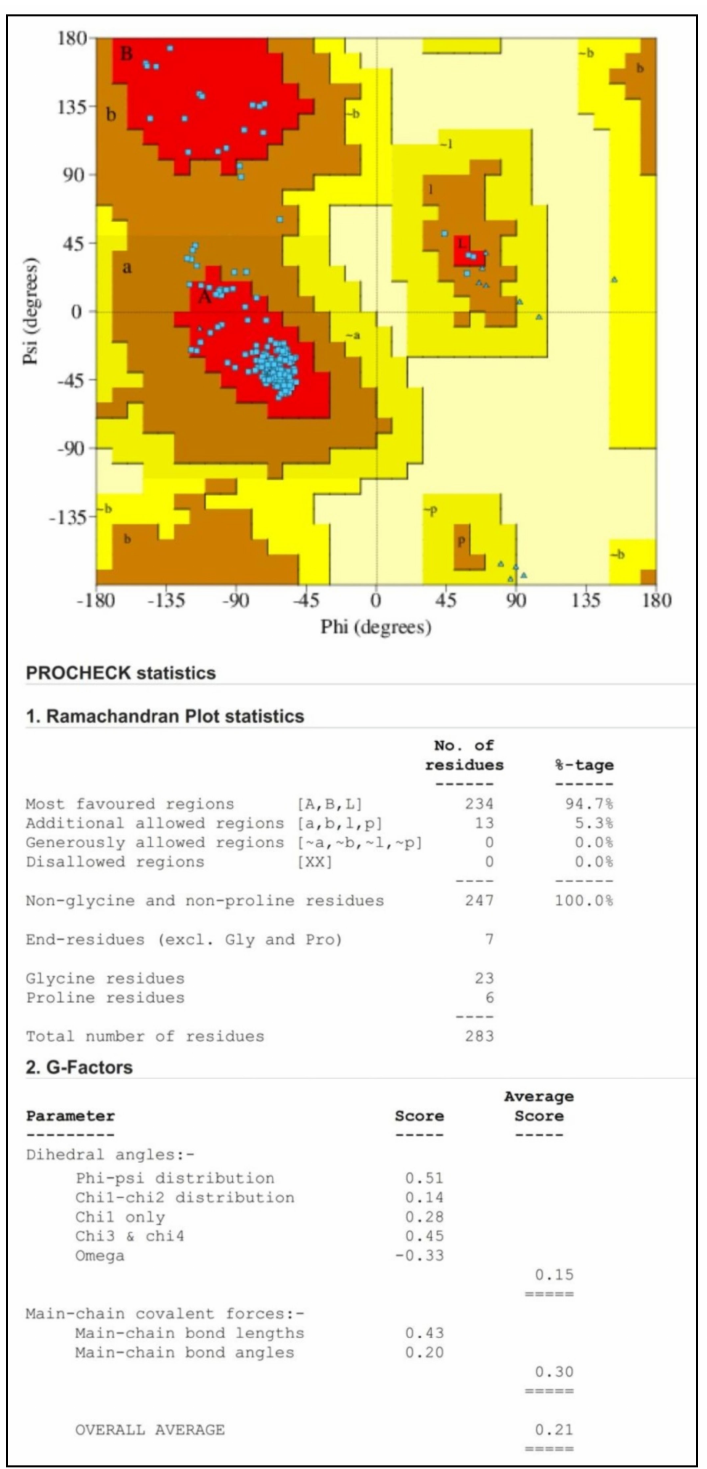
Figure 1. Ramachandran plot analysis of Bcl-2 protein (PDB: 2W3L) structure generated by the PROCHECK web server. The red color regions in the graph indicate protein residues in the most allowed regions; the brown color regions indicate the residues in additional allowed regions; the yellow color regions indicate the residues in generously allowed